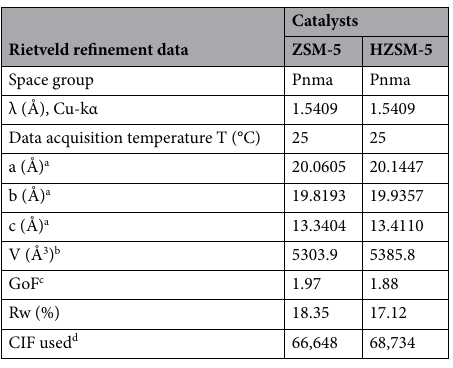
Table 2. Rietveld refinement data of the catalyst. a Cell parameter. b Cell volume. c Goodness of fit. d Crystallograph information.